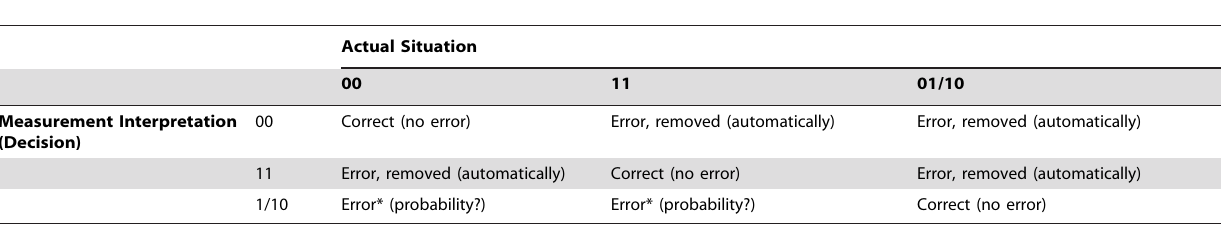
Table 1. Types of errors in the KLJN bit exchange.